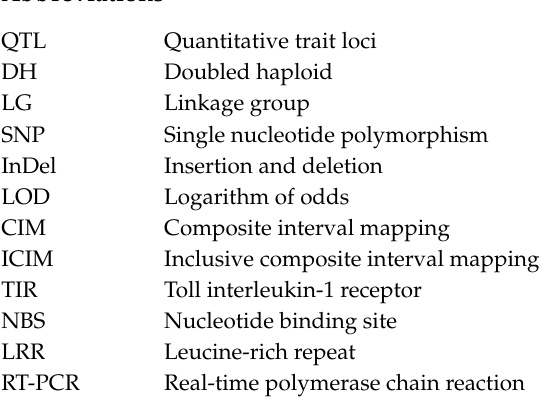
Table S1. Phenotypic trait values of parental lines and the DH population. Table S2. Marker information used to construct linkage map. Table S3. Summary of B. rapa genome sequencing data. Table S4. Distributions of total SNPs and InDels. Table S5. The B. rapa genetic map developed in the present study. Table S6. Clubroot linkage and marker information used on chromosome A08. Table S7. Primer information for this study. Table S8. Clubroot linkage and gene marker information used in the DH